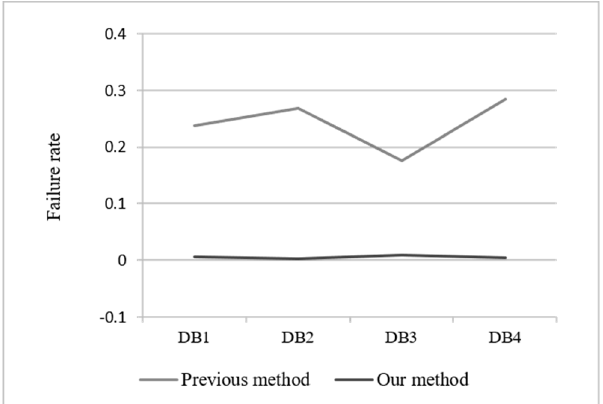
Figure 19. RDB2RDF failure rate of the mapping methods.